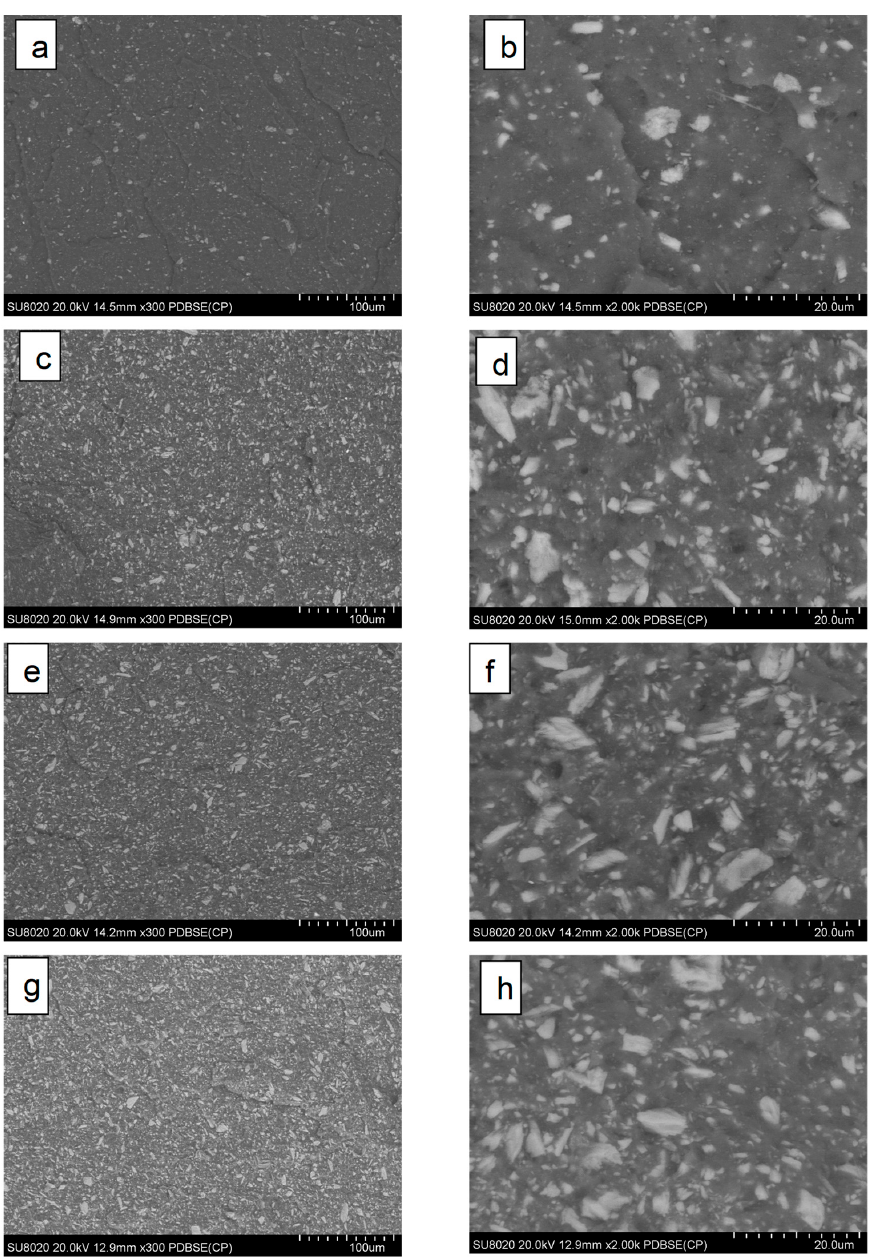
Figure 8. ( a – h ). SEM–BSE pictures at low and high magnification of cryofractured surfaces of PLA − AII composites having different PLA matrices: ( a , b ) PLA1 − 20% AII; ( c , d ) PLA1 − 40% AII; ( e , f ) PLA2 − 40% AII; ( g , h ) PLA3 − 40% AII. ( e , f ) PLA2 − 40% AII; ( g , h ) PLA3 − 40%